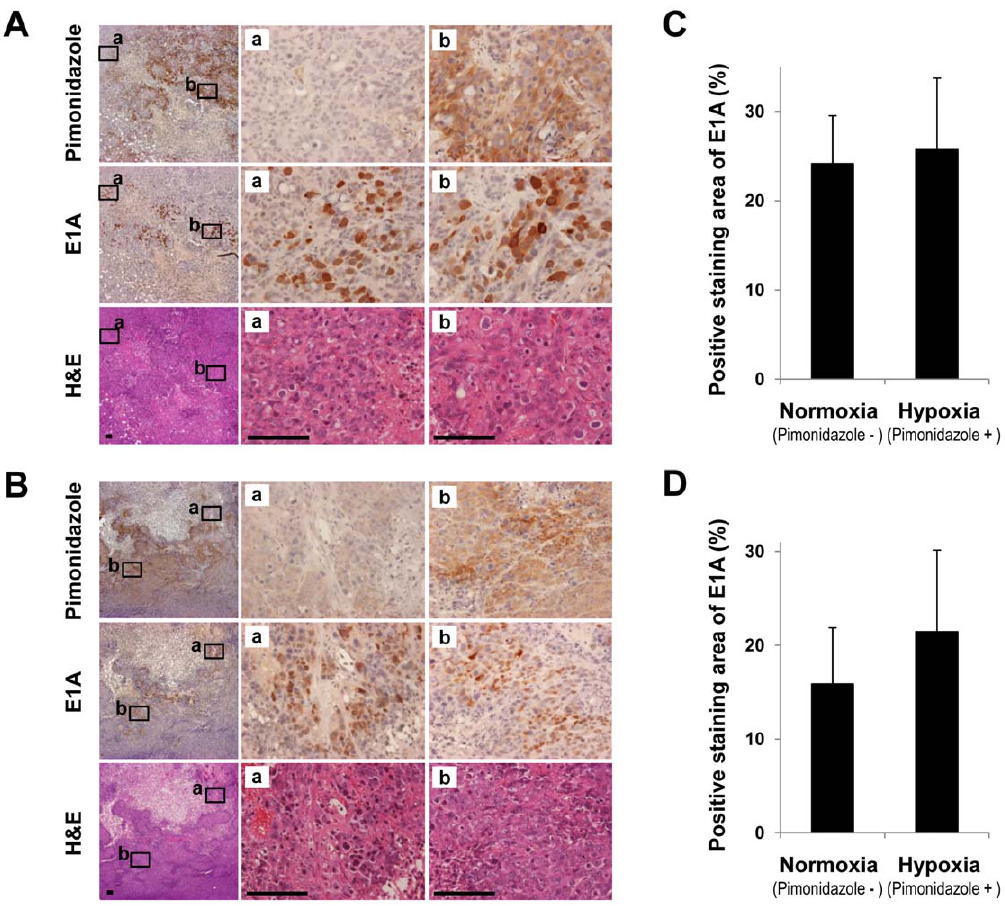
Figure 5. E1A expression in hypoxic areas of human xenograft tumors intratumorally injected with OBP-301. HT29 ( A and C ) and DLD- 1 ( B and D ) tumor cells (5 6 10 6 cells/mouse) were injected subcutaneously into the flank of athymic nude mice. Two weeks after inoculation, OBP-301 (1 6 10 8 PFU/tumor) was injected into the tumor for three cycles every 2 days. One day after final administration of OBP-301, the mice were intraperitoneally injected with the hypoxia marker pimonidazole hydrochloride (120 mg/kg). Thirty minutes after injection of pimonidazole hydrochloride, the mice were sacrificed and the tumors were harvested. Paraffin-embedded sections of HT29 and DLD-1 tumors were stained with hematoxylin and eosin (H&E). Tumor sections were also immunostained with an anti-pimonidazole antibody and an anti-adenovirus E1A antibody. A and B , Middle ( a ) and right ( b ) panels are higher magnifications of the boxed regions in the left panels. Original magnification: 6 4 (left panels), 6 40 (middle and right panels). Scale bars=100 m m. C and D , Quantitative analysis of the E1A-positive areas in the normoxic and hypoxic regions of human xenografts tumor tissues. Data are shown as mean values 6 SD of quadruplicate experiments.